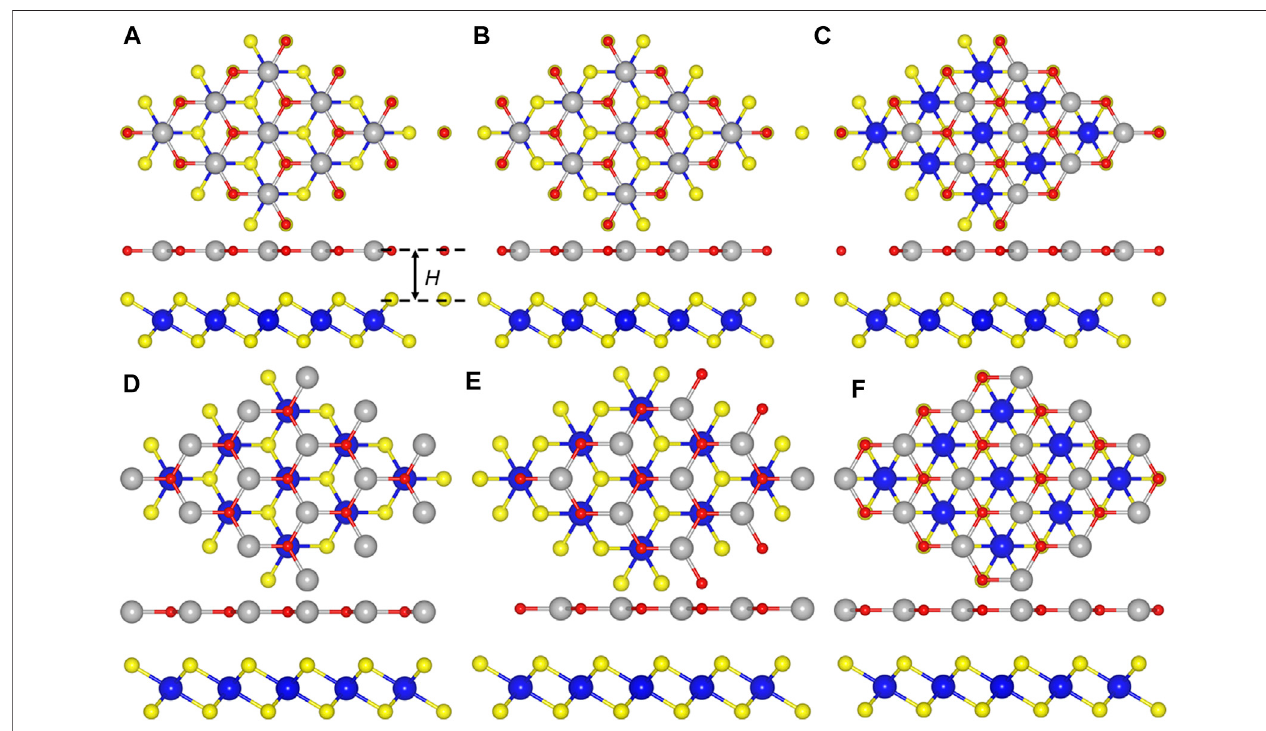
FIGURE 2 | The top and side views of CdO/HfS 2 heterostructure constructed by (A) CH-1, (B) CH-2, (C) CH-3, (D) CH-4, (E) CH-5, and (F) CH-6 con fi gurations.